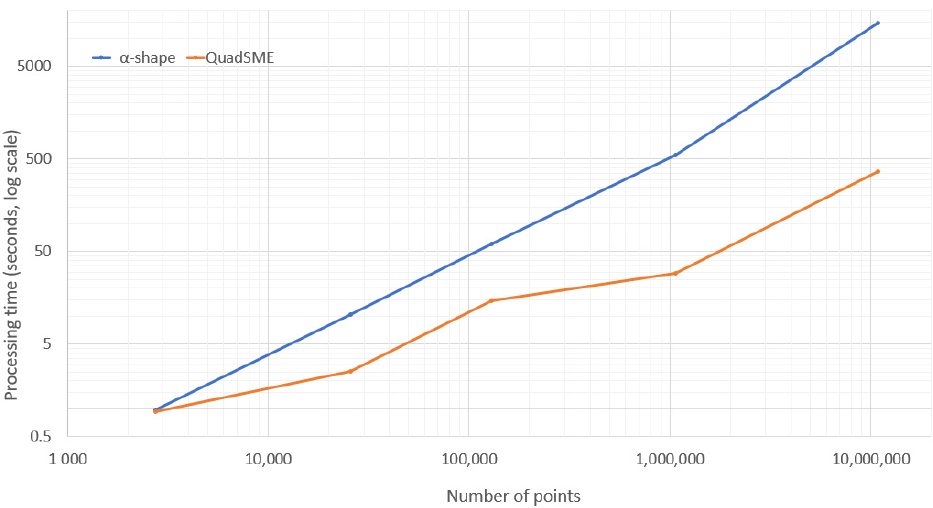
Figure 6. Computation time for α -shape and QuadSME algorithms.